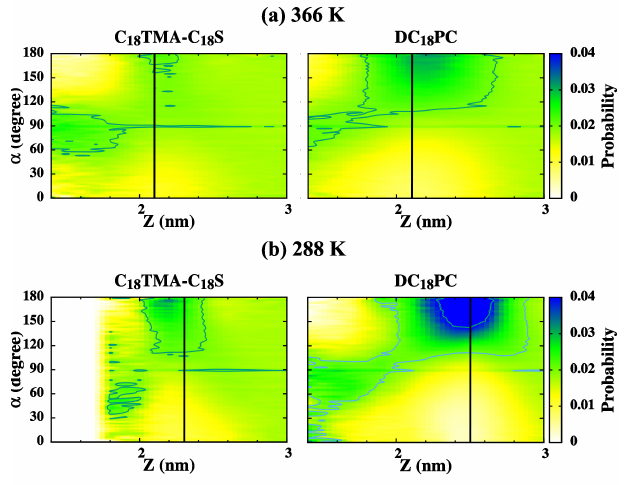
Figure 8. The water orientational angle distributions at various transverse positions, z , for the C 18 TMA-C 18 S IPA and DC 18 PC bilayer at ( a ) 366 and ( b ) 288 K. The black lines denote the most probable positions for the central N atoms of the positively charged trimethylammonium of IPA and choline of PC as marked with star symbols in Figure 7.